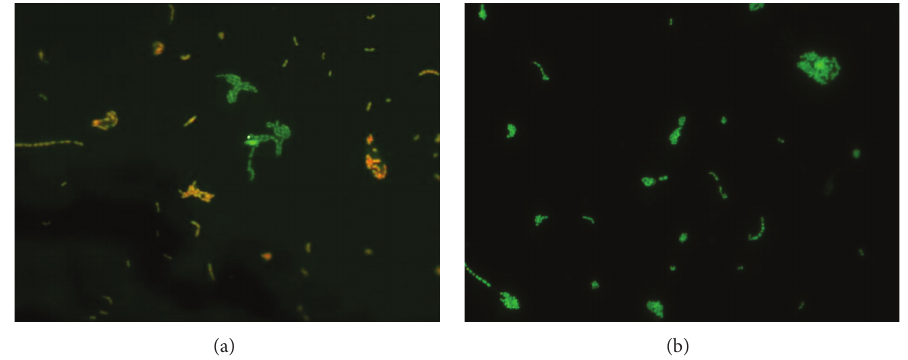
Figure 4: Visualization of adherent bacteria ( Streptococcus mutans ) using epifluorescence microscopy and live/dead staining (1000-fold magnification). Green fluorescent cells depict active bacteria, whereas red fluorescent cells show dead ones. (a) Glass ionomer material; (b) negative control (bovine